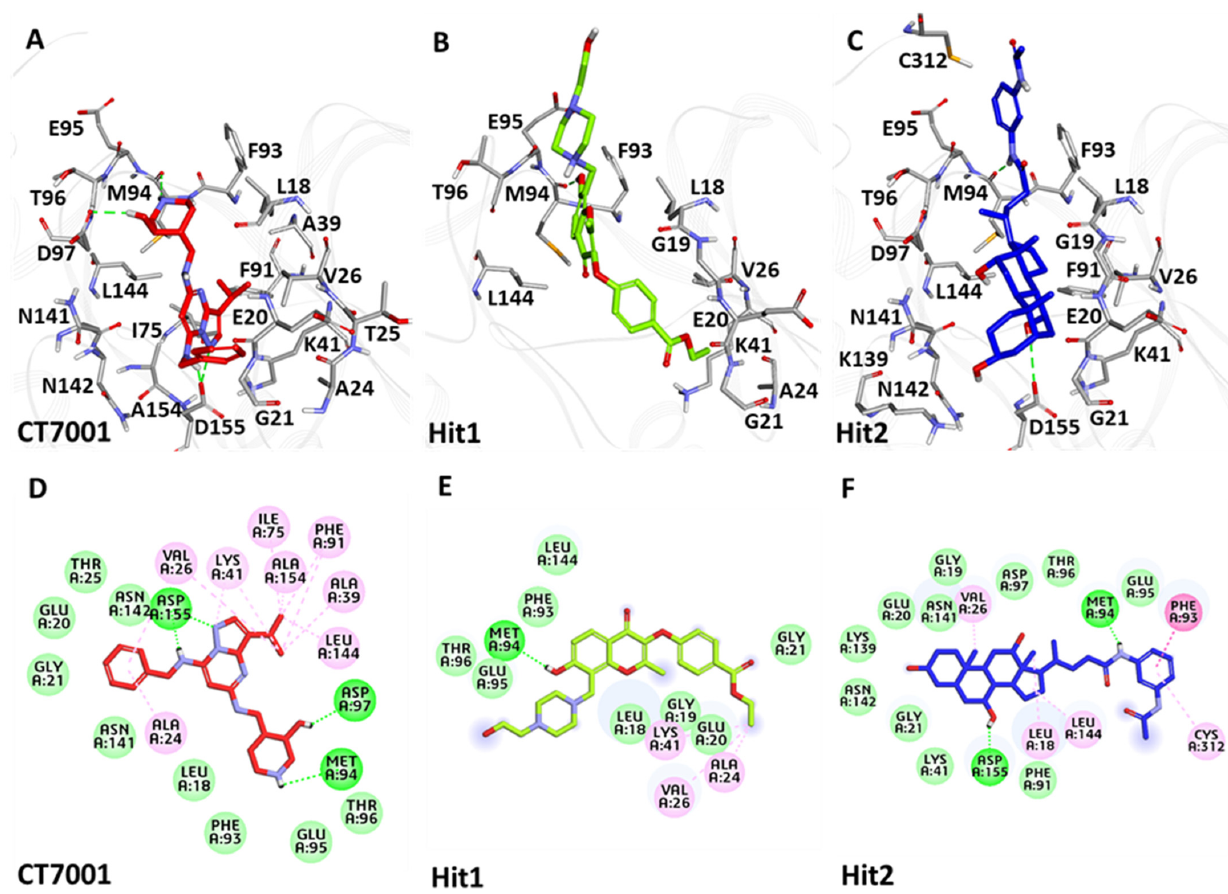
Figure 8. Binding mode and intermolecular interactions of CT7001 ( A , D ), Hit1 ( B , E ), and Hit2 ( C , F ) with CDK7. Upper and lower panel represents the interactions in 3D and 2D, respectively. The protein in the background is shown with grey lines, whereas interacting residues are shown as grey sticks. Dark green dashed lines indicate hydrogen bonds, light green: van der Waals, while the π - π and π -alkyl interactions are shown in pink.